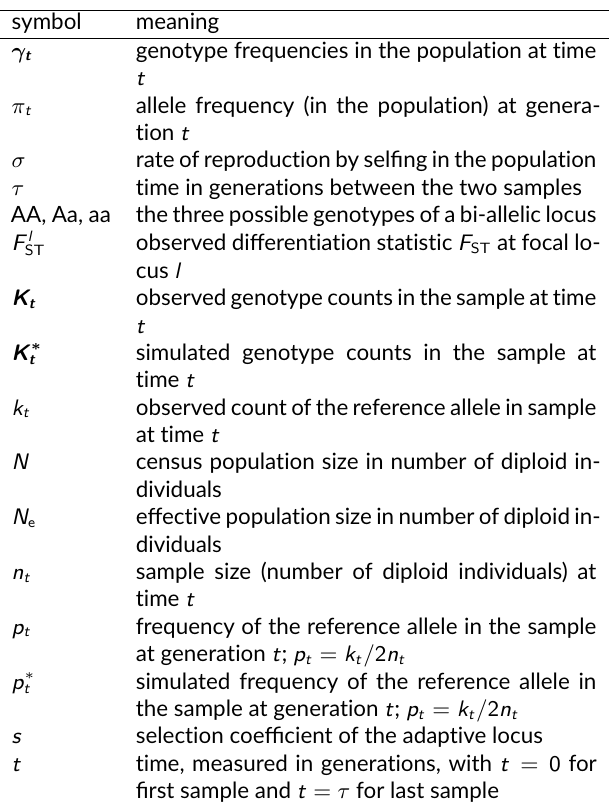
Table 2 – Genome scan results for M. truncatula . This table is provided in a supplementary